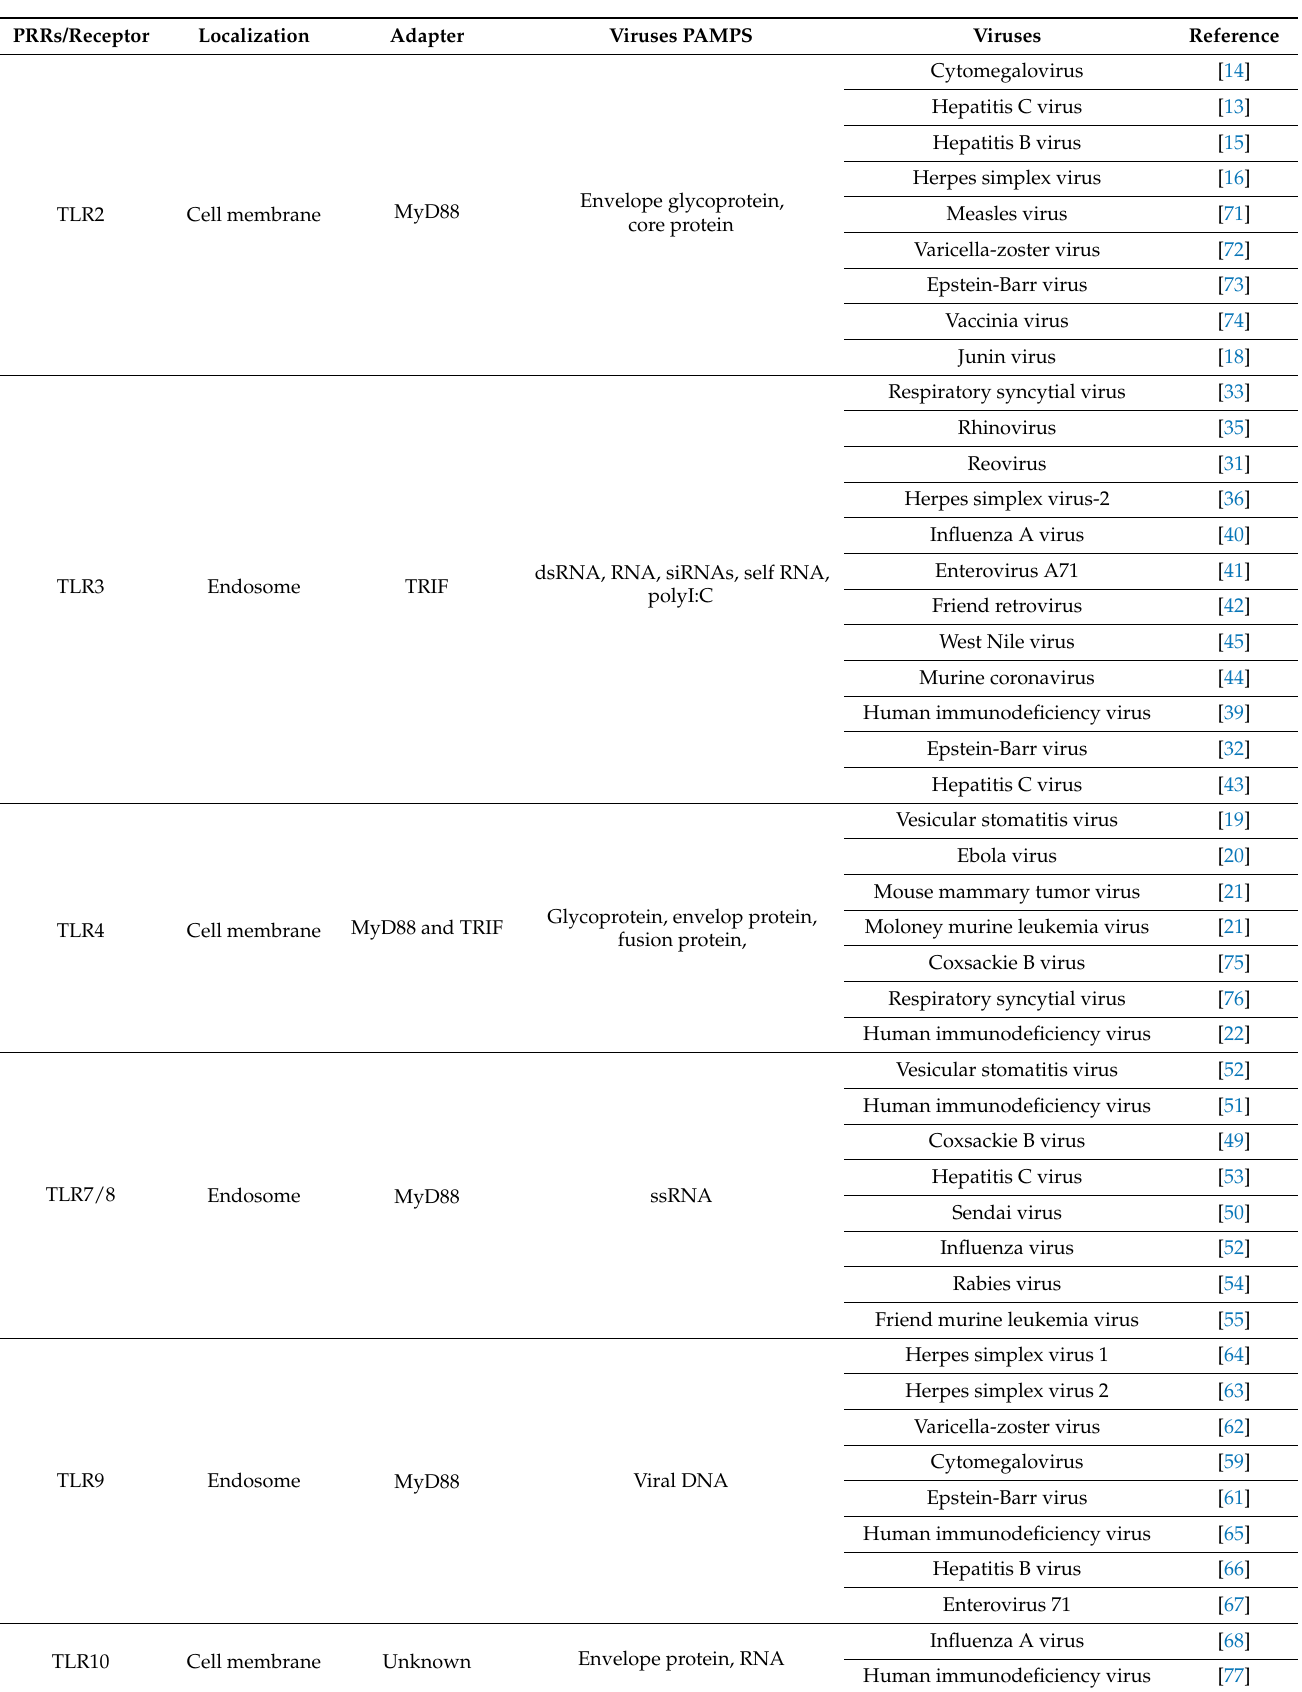
Table 1. Viruses recognized by toll like receptors or